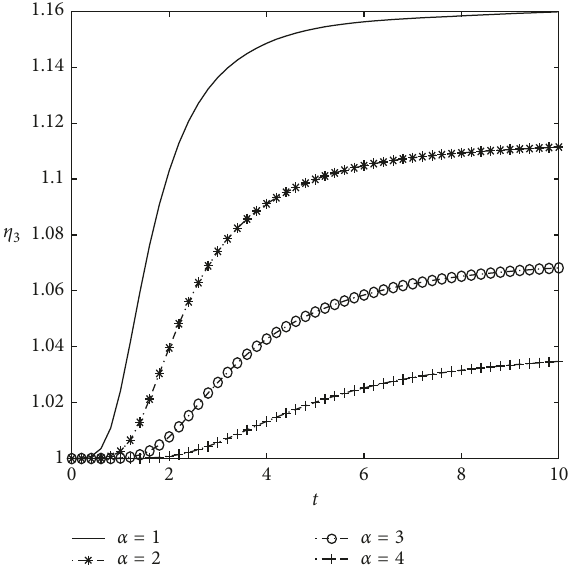
Figure 16: η over time for various values of α when applying the 2 fourth nonlinear adaptive controller.